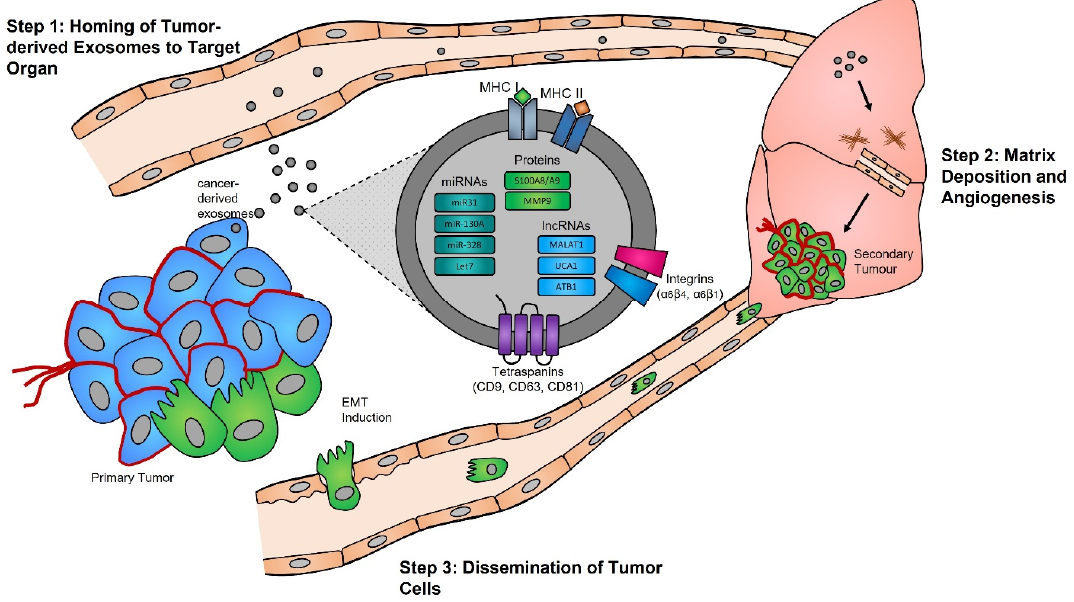
Figure 1. Exosomes and pre-metastatic niche formation. Exosomes released from primary tumors into the circulatory system specifically home to distant target organs (step 1). Upon their arrival, tumor-derived exosomes actively prepare the pre-metastatic niche through myofibroblast activation, induction of angiogenesis, and ECM remodeling (step 2). Local invasion of the primary tumor by cancer cells is followed by their intravasation into the tumor vasculature. These cancer cells survive and travel within the circulatory system, and upon their arrest in capillaries at distant sites, they extravasate into the parenchyma of target organs to commence metastatic colonization (step 3).